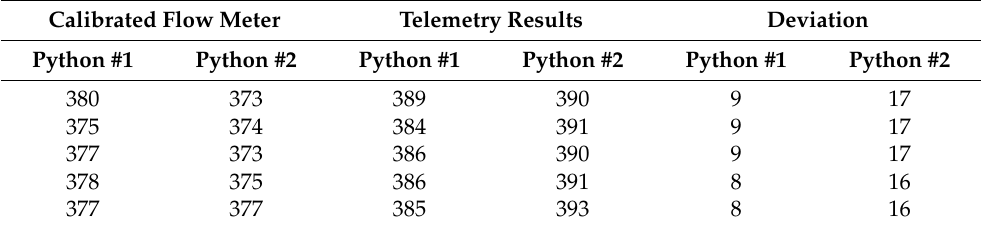
Table 1. Number of impulses in slow tapping during 60 s period for 1